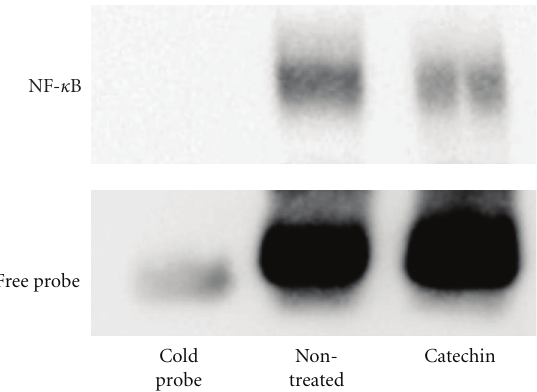
Figure 1: Gel mobility shift assay of cardiac transplantation. Gel mobility shift assay documented that increased NF- κκ B binding activity was observed in nontreated allografts. This enhanced NF- κ B binding was reduced by catechin administration (20 mg/kg/day, THEA-FLAN 90S).